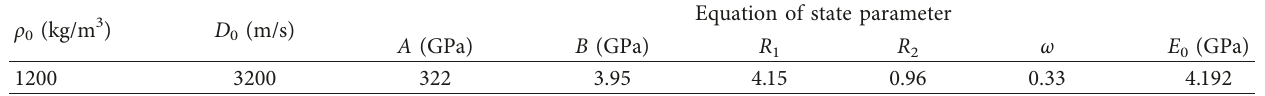
Table 1: Explosive